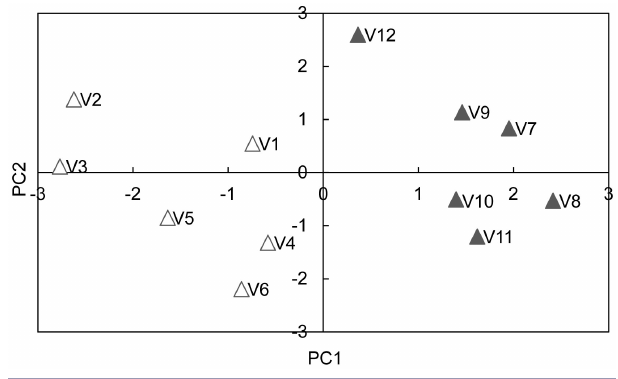
Fig. 2 . Distribution of surveyed sites (V1-V6: abandoned villages; V7-V12: inhabited villages) in the PC1-PC2 space produced by the principal components analysis of vegetation variables.